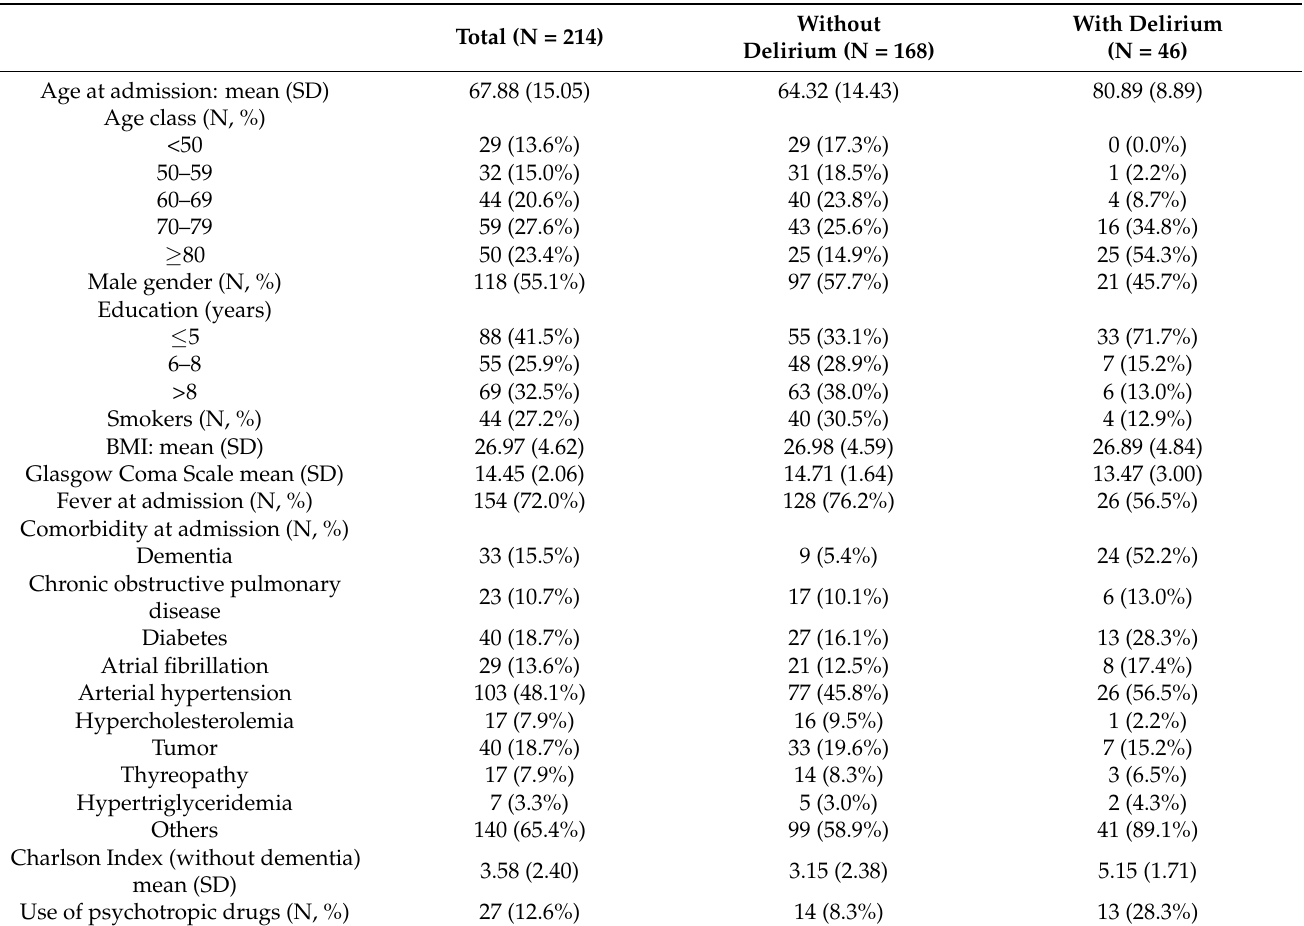
Table 1. Frequency of demographics and clinical characteristics at admission in COVID-19 patients with and without delirium. Without With Total (N = 214) Delirium (N = 168)